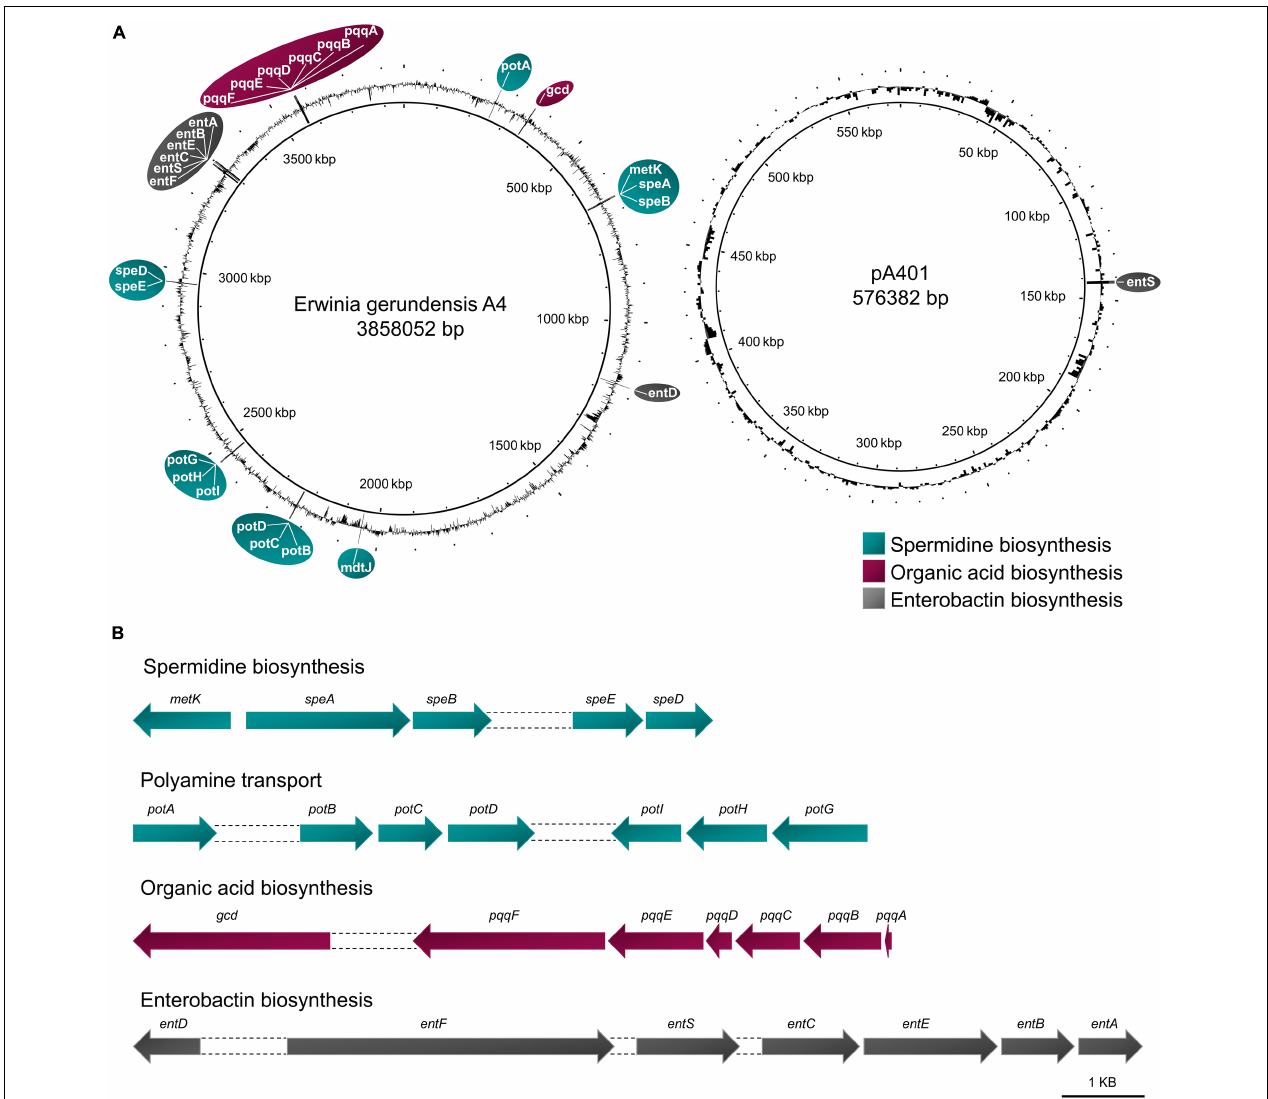
FIGURE 6 | Genes encoding for plant-promoting traits in E. gerundensis strain A4. (A) Location and (B) cluster of genes encoding production and transport of spermidine, the phosphate-solubilizing gluconic acid, and the siderophore